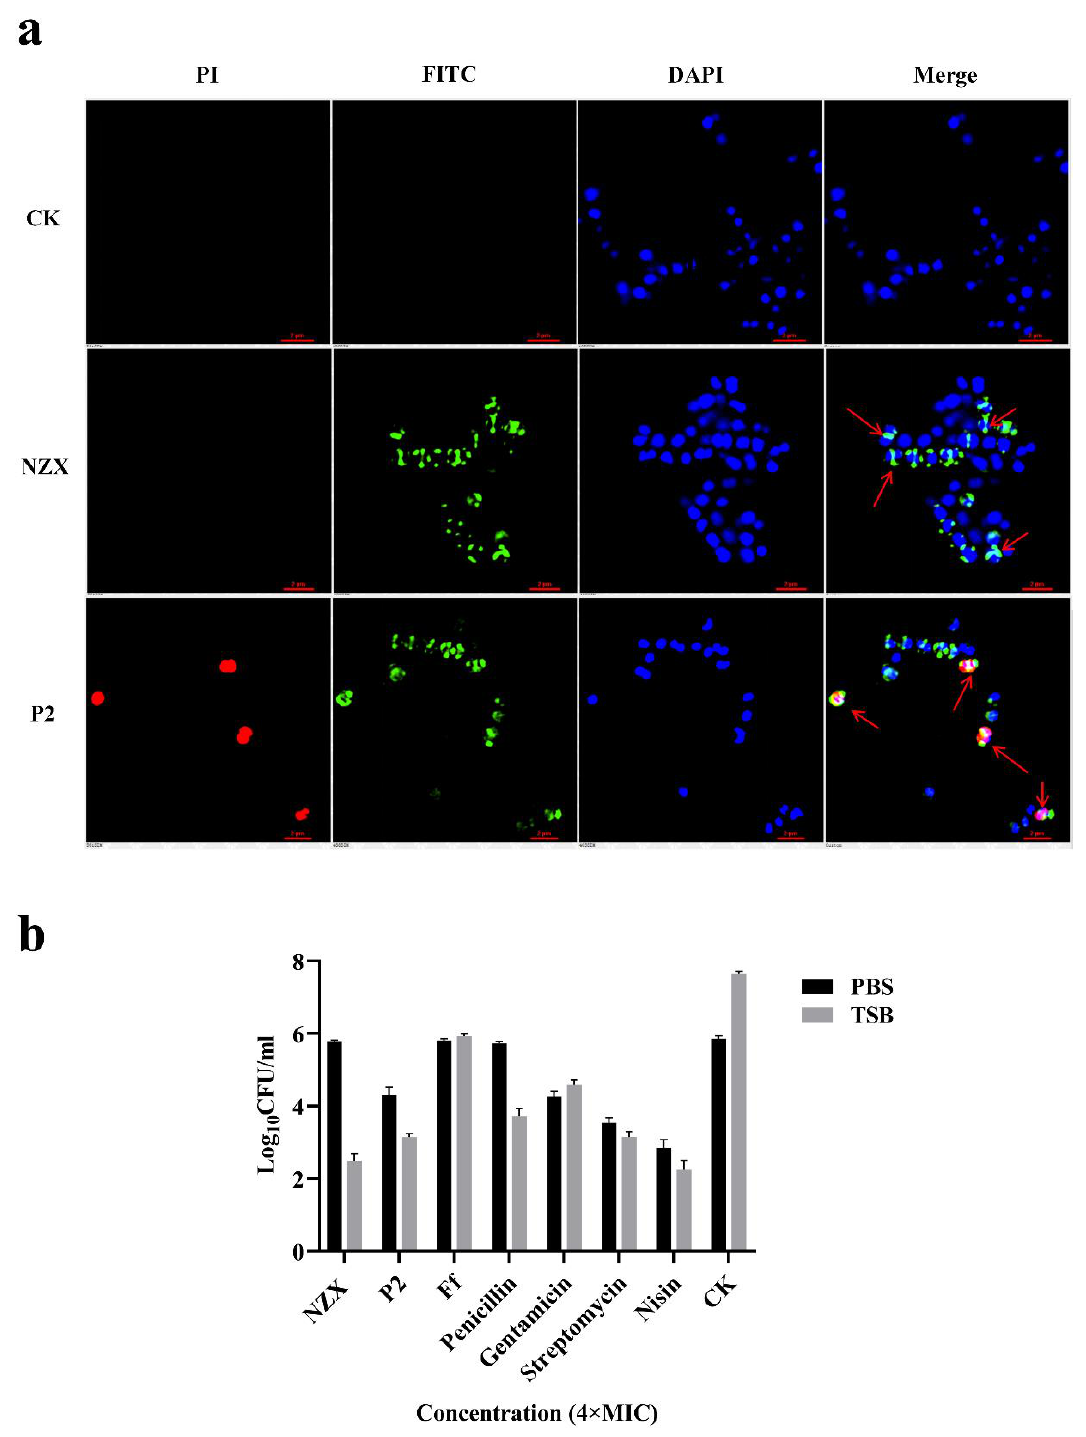
Figure 4. Localization of FITC-labeled peptides on cells and bactericidal ability of peptides on quiescence and division period bacteria: ( a ) SRM observations of localization of FITC-labeled NZX and P2 on S. agalactiae ACCC 61733 cells. The S. agalactiae cells were treated with 4× MIC FITC-labeled NZX and P2 for 30 min, respectively. ( b ) The bactericidal ability of NZX and P2 to S. agalactiae cells on quiescence and division period (suspended in PBS and TSB broth). The S. agalactiae cells were treated with NZX and P2 (2× and 4× MIC) for 2 h, respectively. CK was the untreated group. Table 4. The effect of lipid II analogues on the antibacterial activity of peptides.